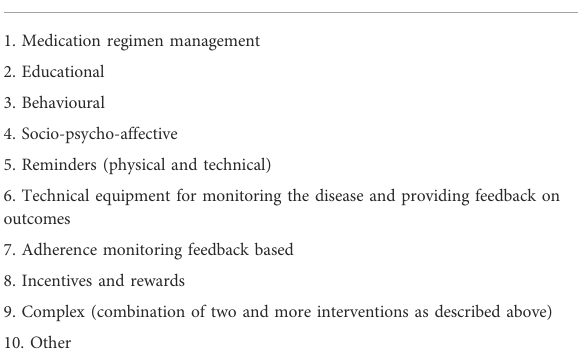
TABLE 1 Medication adherence enhancing interventions ’ taxonomy adopted for this